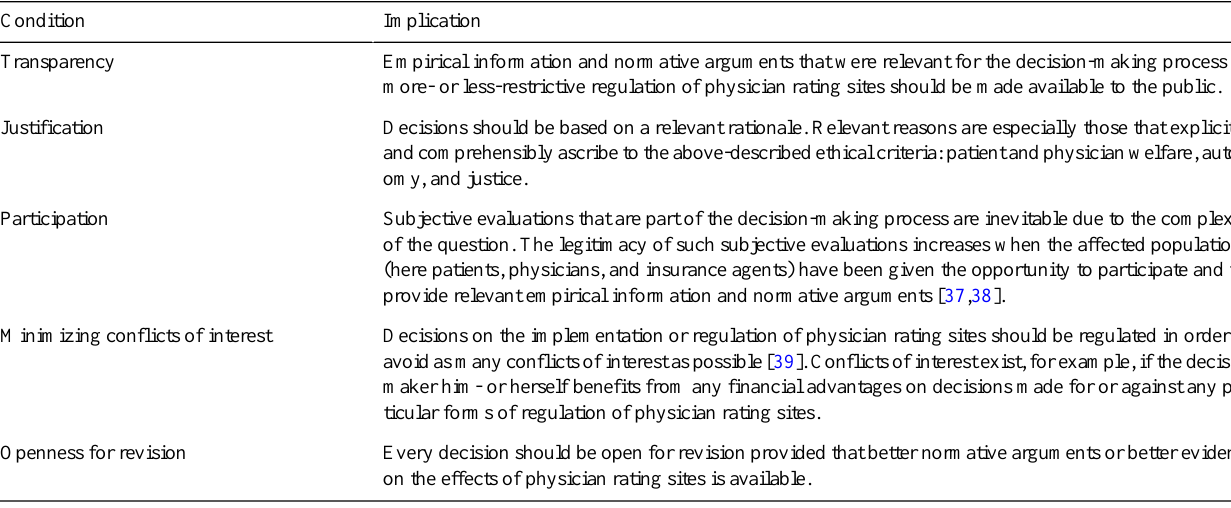
Table 2. Basic conditions for a fair decision-making process concerning the implementation and regulation of physician rating sites